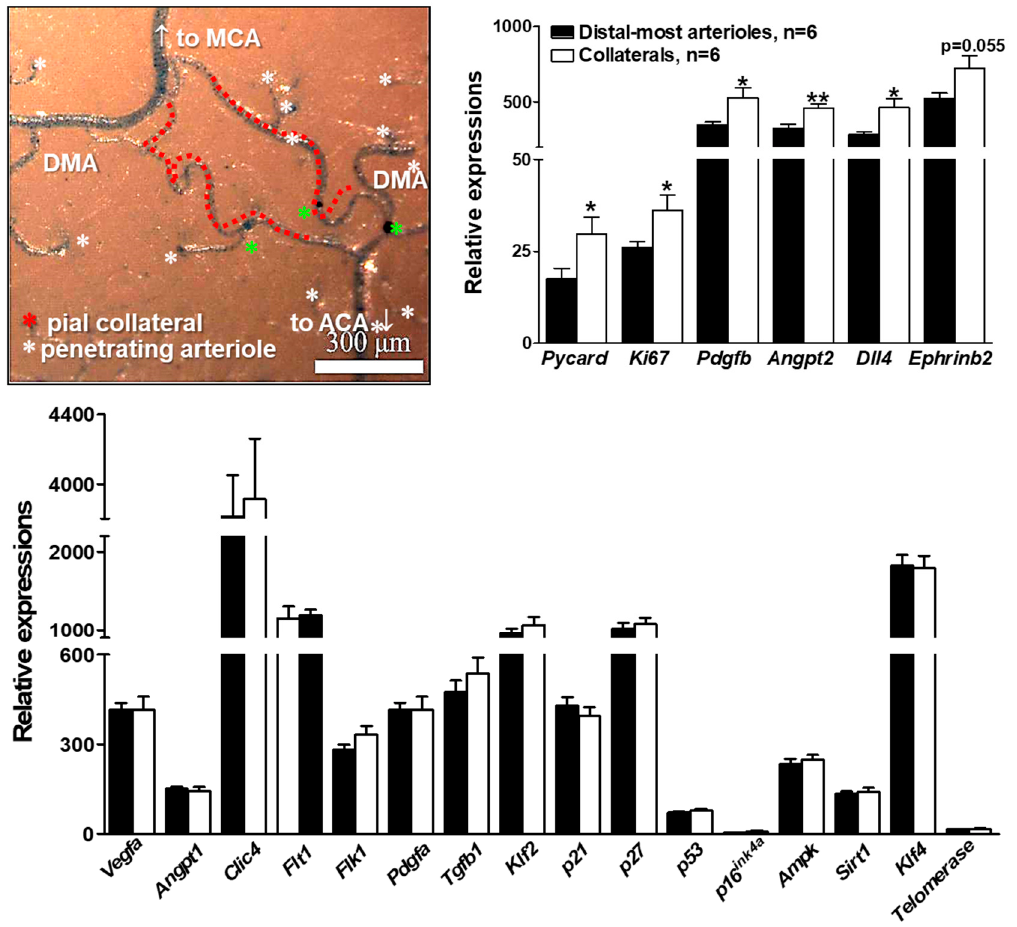
Figure 6. Gene expression differs for collaterals versus distal-most arterioles. Upper left panel, pial arterial vasculature perfusion-fixed at maximal dilation then filled with PU4ii polyurethane. Stars identify penetrating arterioles, including three that bifurcate and descend into the cortex immediately below the arteriole or collateral (green stars). Ten collaterals and 10 nearby similarly-sized distal-most arterioles DMAs were dissected from each of 36 mice and pooled into six samples for extraction of RNA. Transcript abundance was determined by Nanostring n-Counter ® for 22 genes, each normalized to one of six housekeeping genes ( Gapdh, β actin, Tubb5, Hprt1, Ppia, Tbp ) selected for comparable level of expression [46]. * p < 0.05, ** p < 0.01 by 2-sided t-test for collaterals versus DMAs.